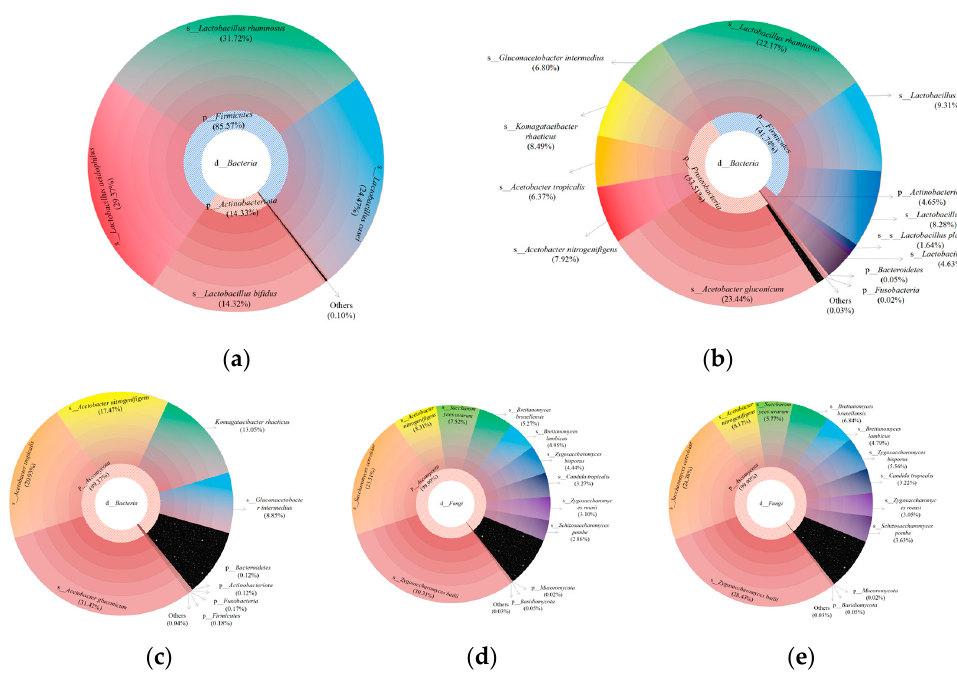
Figure 4. Multistage bacterial species composition for the soy milk samples ( a ) L, ( b ) LK1.0, and ( c ) K. Multistage fungal species composition for the soy milk samples ( d ) LK1.0 and ( e ) K.